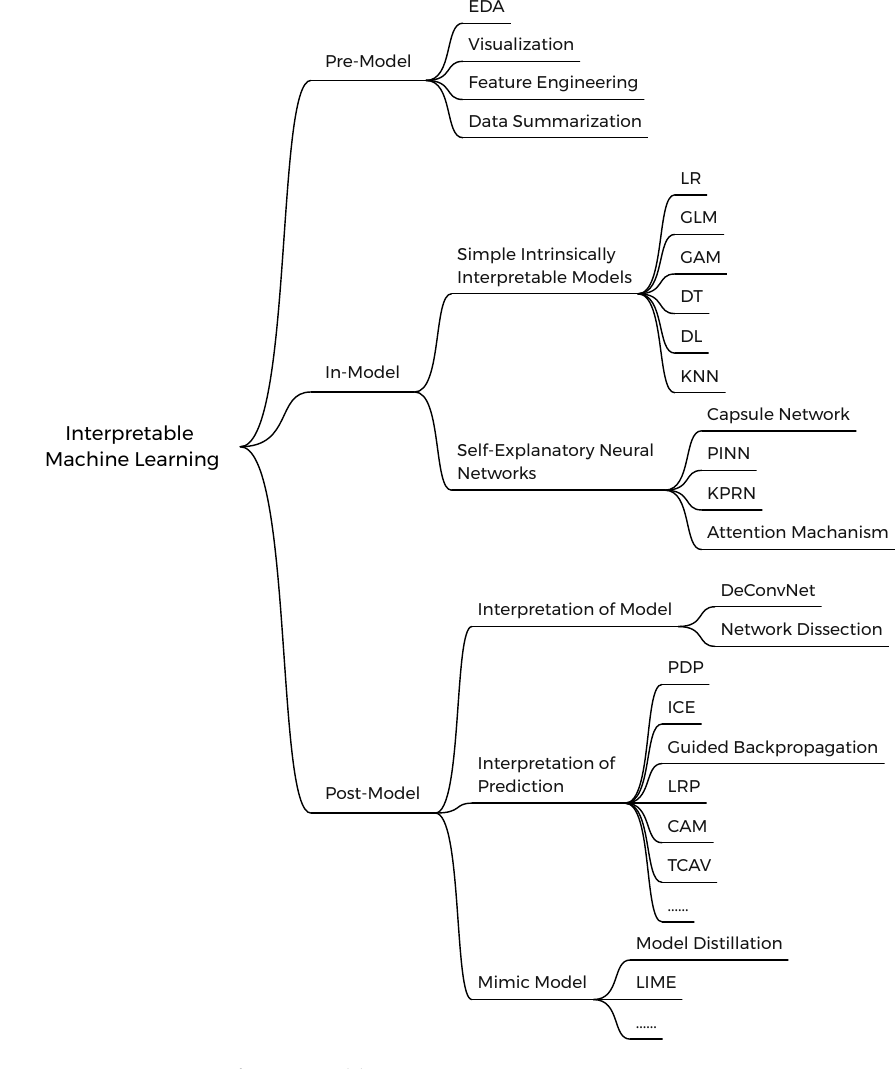
Figure 4. Taxonomy of interpretable